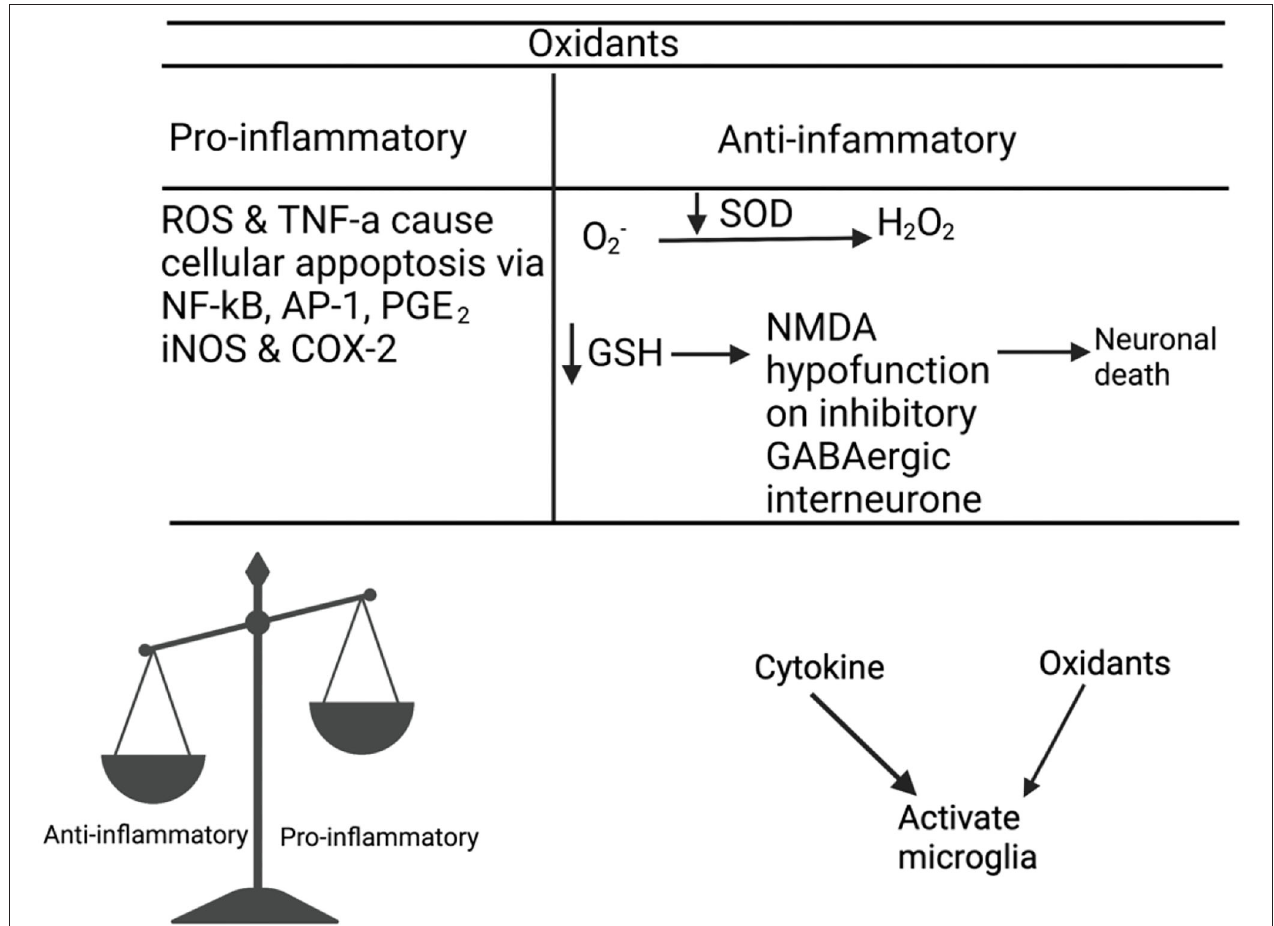
FIGURE 3 | Matsubara and Ziff (59) and Meier et al. (60) reported an interaction between cytokines and oxidants, where they observed the role of TNF- α , IL-1, and IFN- γ in ROS production. Janssen-Heininger et al. ( 61) Sidoti-de Fraisse et al. (62), and Loukili et al. (63) reported that ROS and TNF- α have a synergistic effect on cell apoptosis via active transcription factors, nuclear factor kappa-light-chain-enhancer of activated B cells (NF-kB), and activator protein-1 (AP-1). The increased pro-inflammatory expression, NF-kB, PGE 2 , iNOS, and COX-2 are unique in patients with schizophrenia compared to bipolar patients or healthy controls ( 64). Oxidative stress reduces the levels of antioxidants such as glutathione (GSH) ( 65–69) and glutamate release from microglia (70). Depleted GSH levels cause NMDA hypofunction in inhibitory GABAergic interneurons (71), which fail to mediate inhibitory and excitatory balance of the microcircuitry, resulting in the loss of synapses or neuronal death ( 72). Incomplete reduction of oxygen generates superoxide anion (o − 2 ), which is converted to hydrogen peroxide (H 2 0 2 ) by superoxide dismutase (SOD). SOD is an antioxidant enzyme that prevents oxidative damage from hydroxyl radicals and lipid peroxidation (73). A meta-analyses (74) confirmed that there is